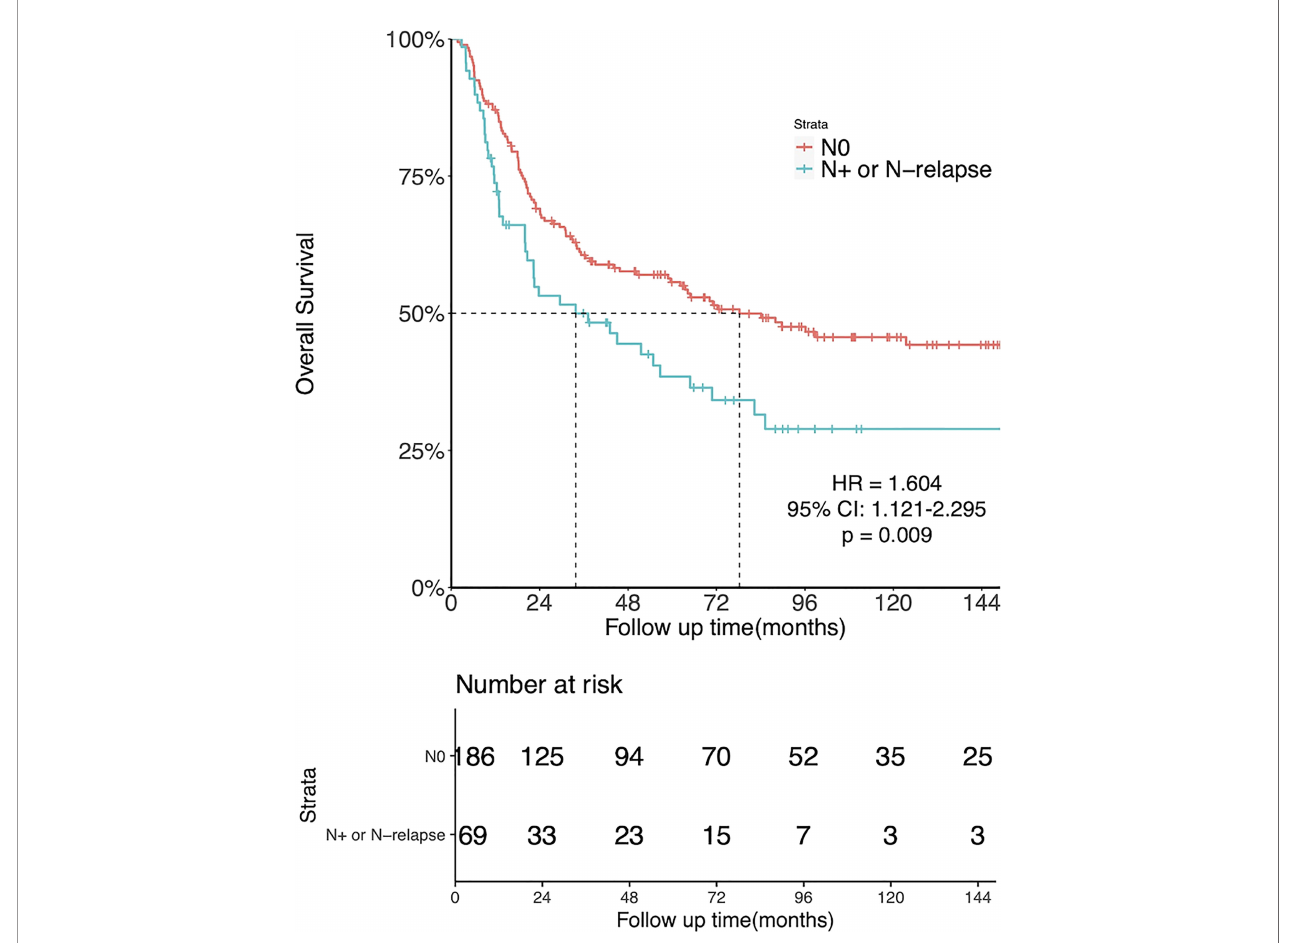
FIGURE 3 | Kaplan-Meier estimates of OS in N0 patients and patients with N+ or N-relapse